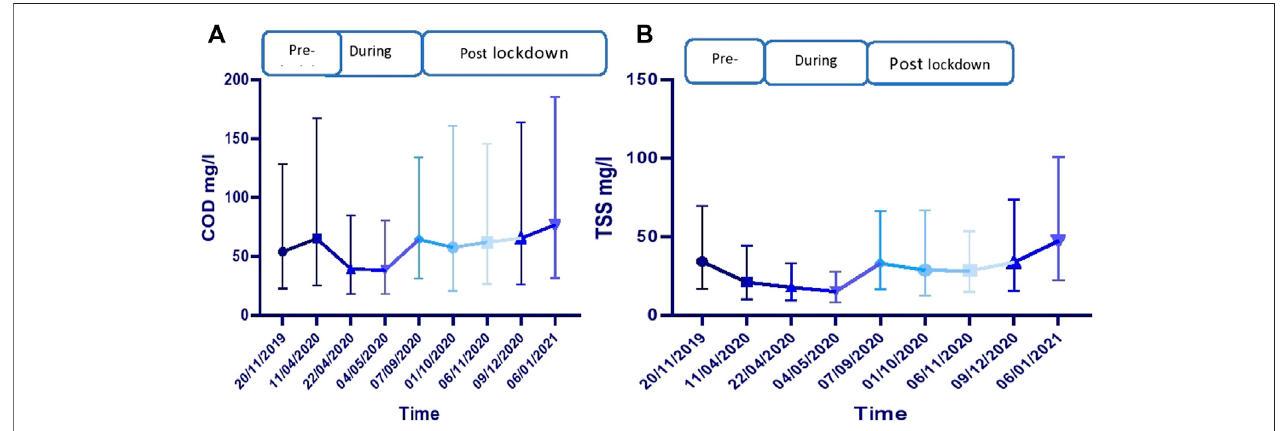
FIGURE 4 | Time series plot for the COD and TSS values during the pandemic in Yamuna river.